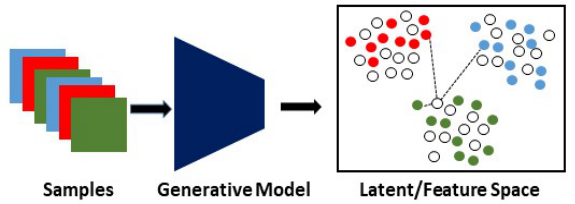
Figure 8. Illustration of SSL with a generative model. All samples are mapped to the latent space (colored points indicate labeled samples from different classes, whereas uncolored points are unla- beled samples). The unlabeled samples are classified according to their distances (dashed lines in the graph) to the labeled samples (cf. clustering). The example point should be green, as the closest labeled neighbors are